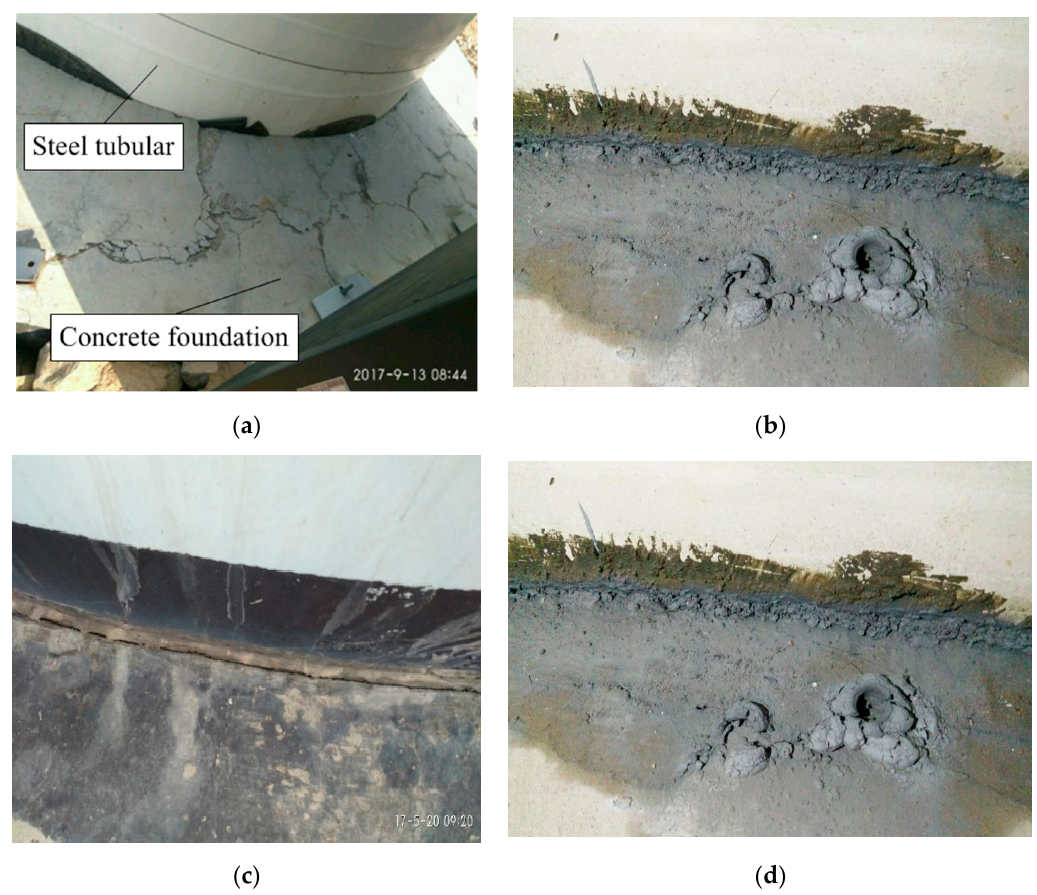
Figure 1. Damages of an embedded-ring foundation. ( a ) Surface cracks; ( b ) Concrete leaching; ( c ) Gaps; ( d ) Visual detection in a bore hole: cracking above the T-shaped plate.